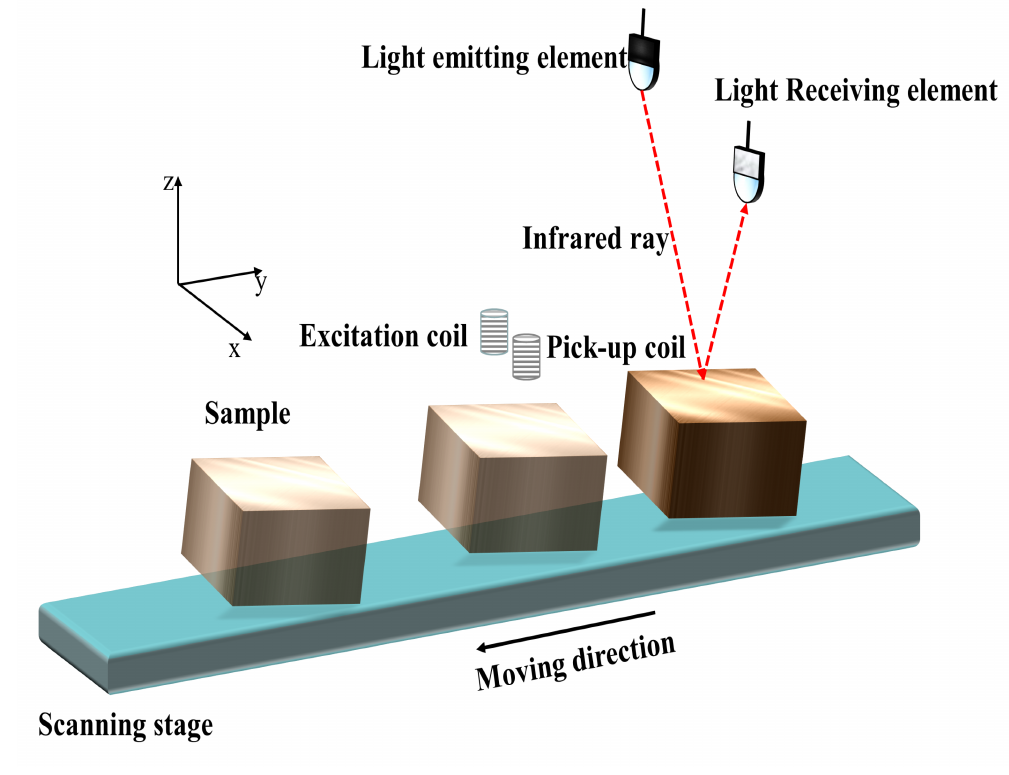
Figure 1. Setup model of the experiment.